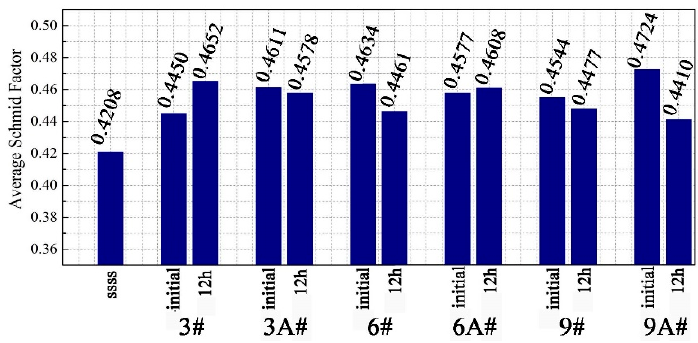
Figure 6. Schmidt factor evolution through compressive creep test.